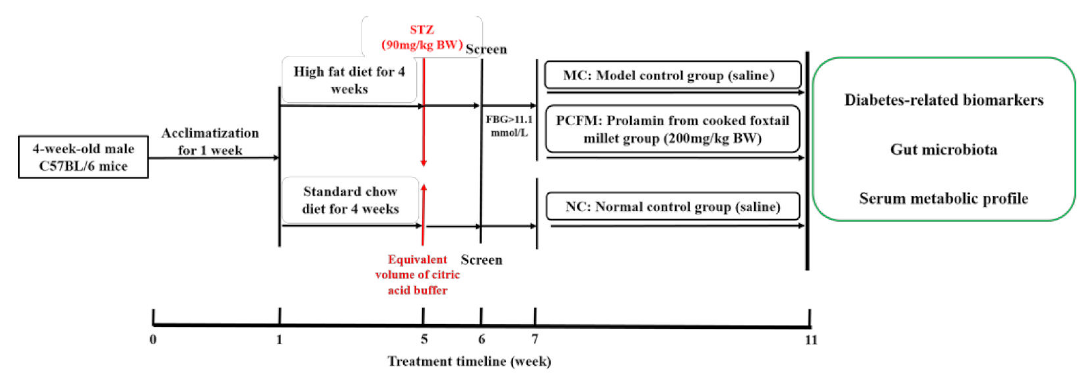
Figure 1. Experimental design. After acclimatization for 1 week, 5-week-old male C57BL / 6J mice were fed with a high-fat diet (HFD) or standard chow diet for 4 weeks. At the 5th week, male C57BL / 6J mice were injected with streptozotocin (STZ) intraperitoneally at the dose of 90 mg / kg body weight (BW). One week after STZ injection, fasting blood glucose (FBG) was measured and mice with FBG levels > 11.1 mmol / L were considered as diabetic mice, and randomly allocated to the model control group (MC, administrated with saline by oral gavage) or the prolamin from cooked foxtail millet group (PCFM, administrated with 200 mg / kg BW PCFM by oral gavage). After five weeks’ treatment, the e ff ects of PCFM on the diabetes-related biomarkers, gut microbiota and serum metabolic profiles of diabetic mice were